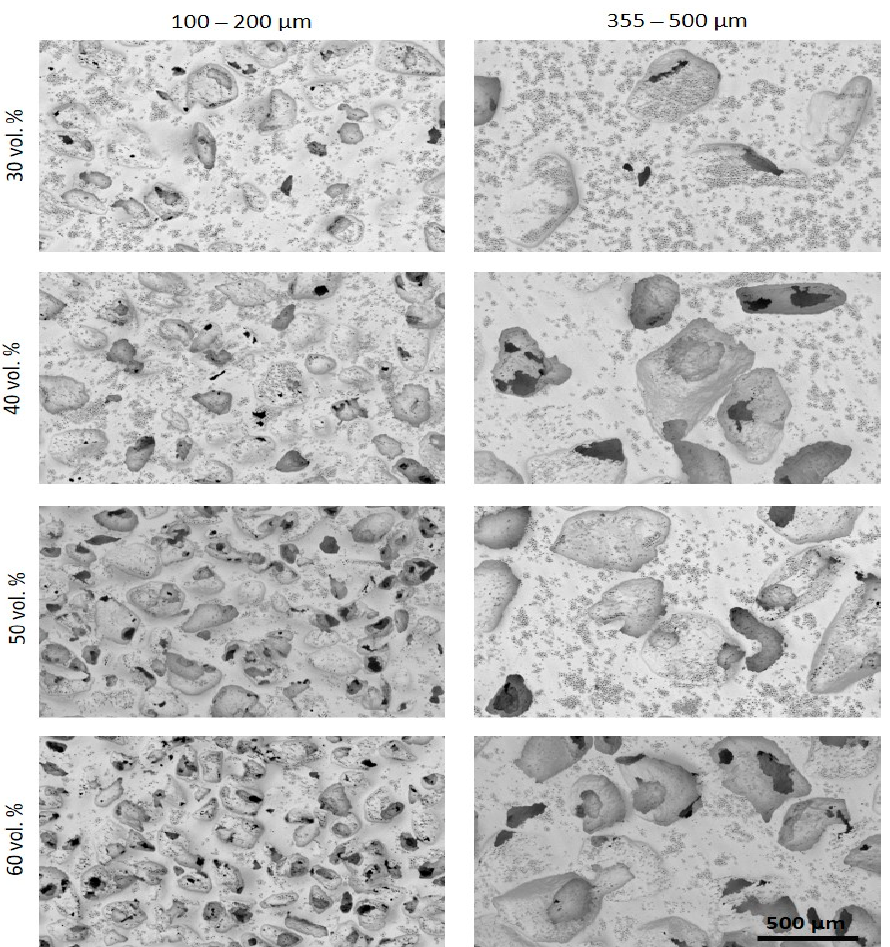
Figure 3. SEM images after the femtosecond laser treatment of the different porous c.p. Ti substrates. Images acquired using the topography view configuration gather both material and topographic contrast with the unique segmented in-lens backscattered electron detector (BSE). Common scale bar for all subfigures.